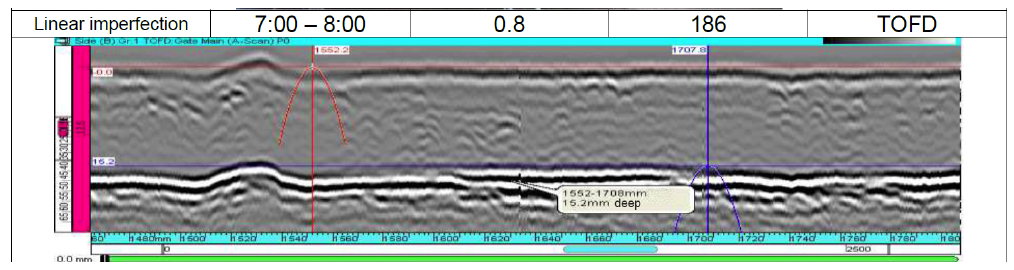
Figure 11. Picture of GW 18540.